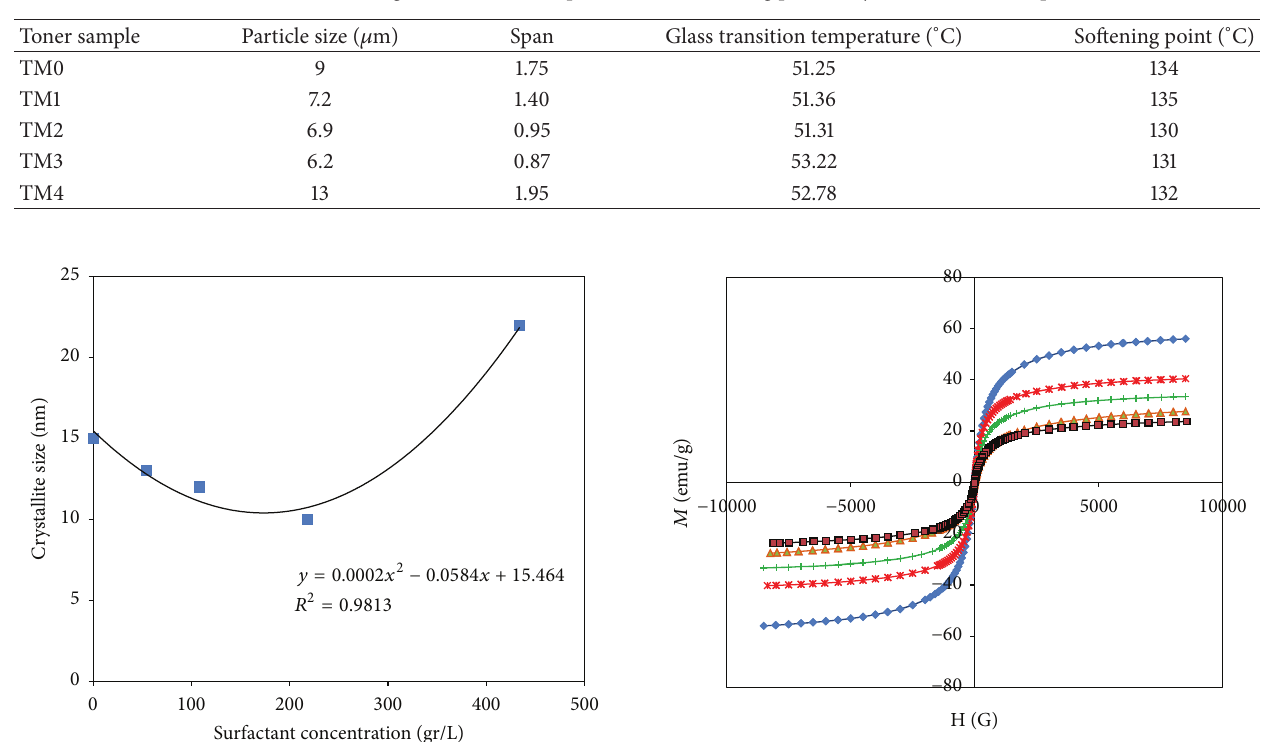
Table 2: Particle size, glass transition temperature, and softening point of synthesize toner samples.